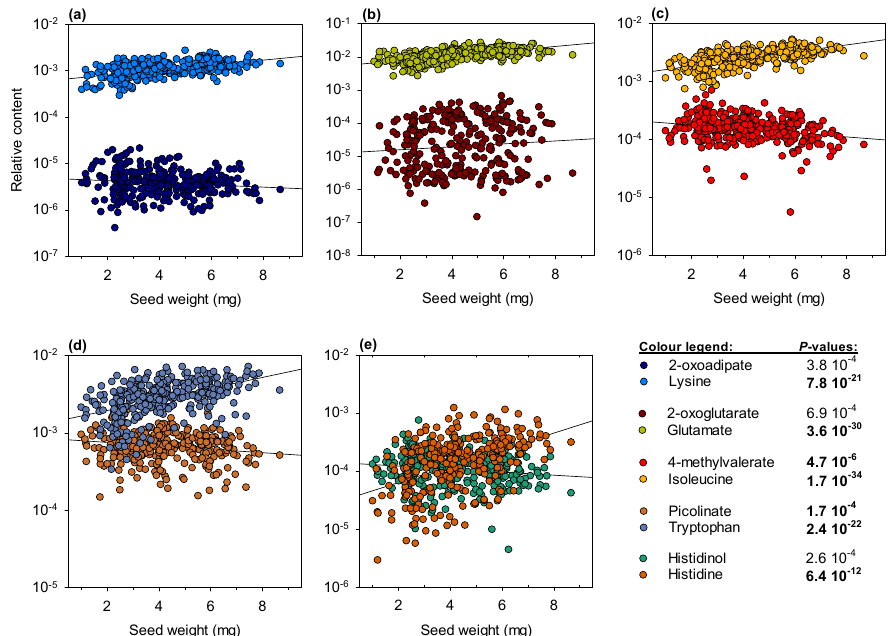
Figure 4. Amino acid degradation products. The relationship between seed weight and relative content in amino acids and their respective degradation products detected in the seed metabolome. Black lines stand for linear regression. Note that a log-scale has been used on the y -axis. For each metabolite of interest, p -values associated with the regression are indicated on the right-hand side. Values below the Bonferroni-corrected threshold (2.04 × 10 − 4 ) appear in bold.